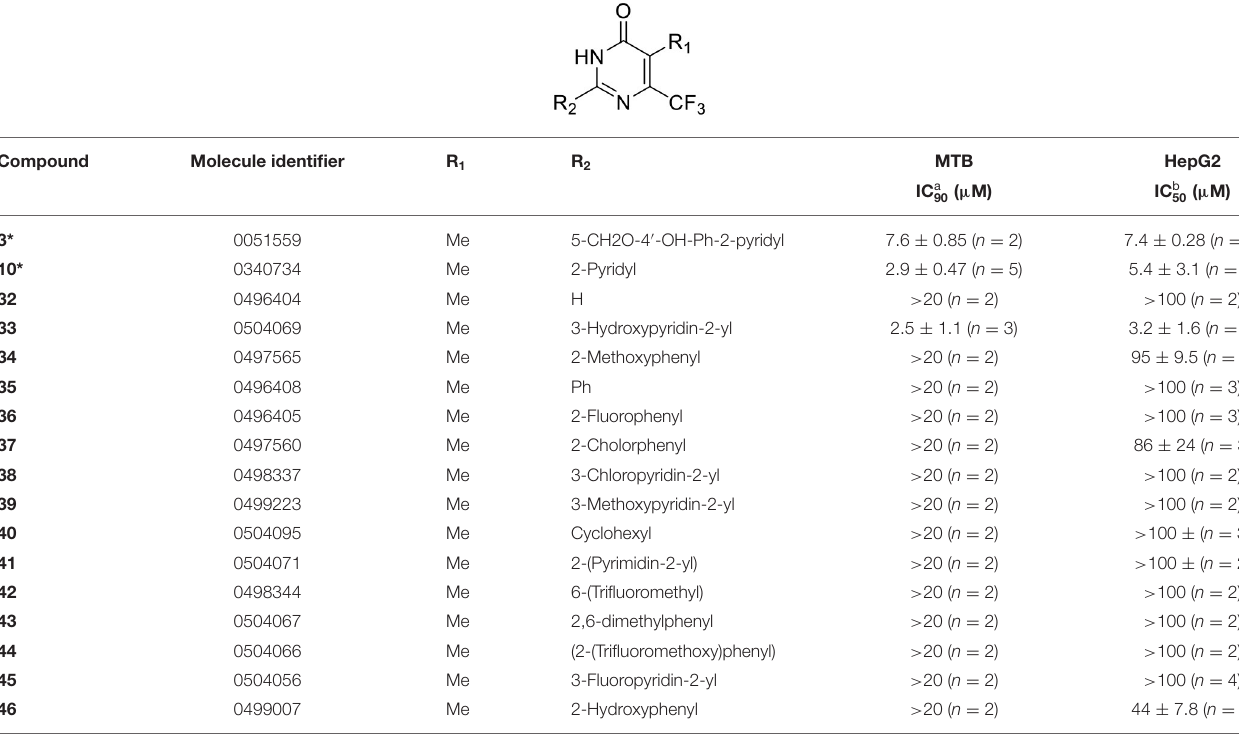
TABLE 2 | Activity of compounds with substitutions at the 2- and 5-positions of the pyrimidinone.